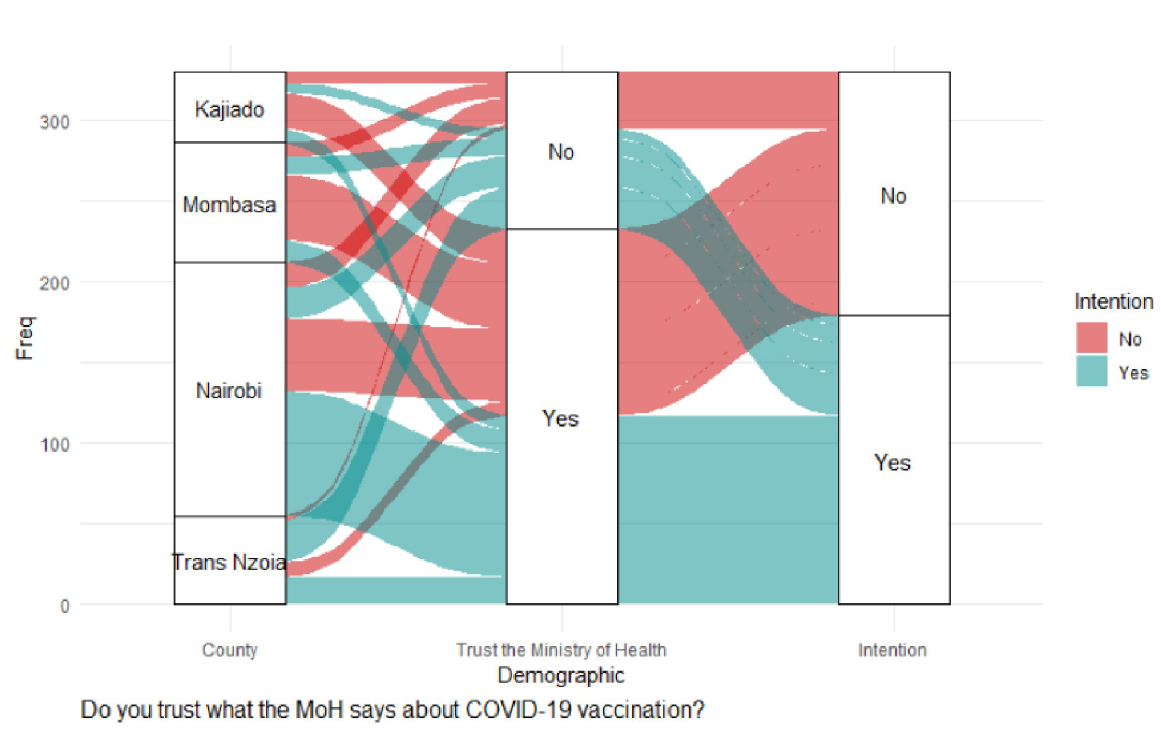
Fig 3. Trust the MOH on COVID-19 vaccination.